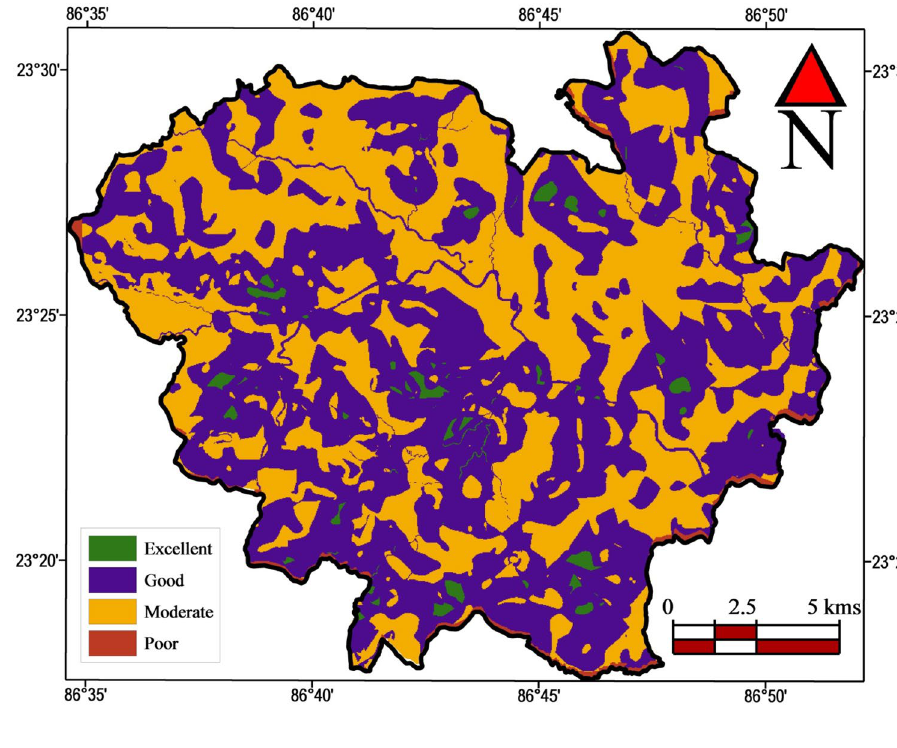
Fig. 10 Hydrograph represent- ing variation in water tables (meters.) for both sampling